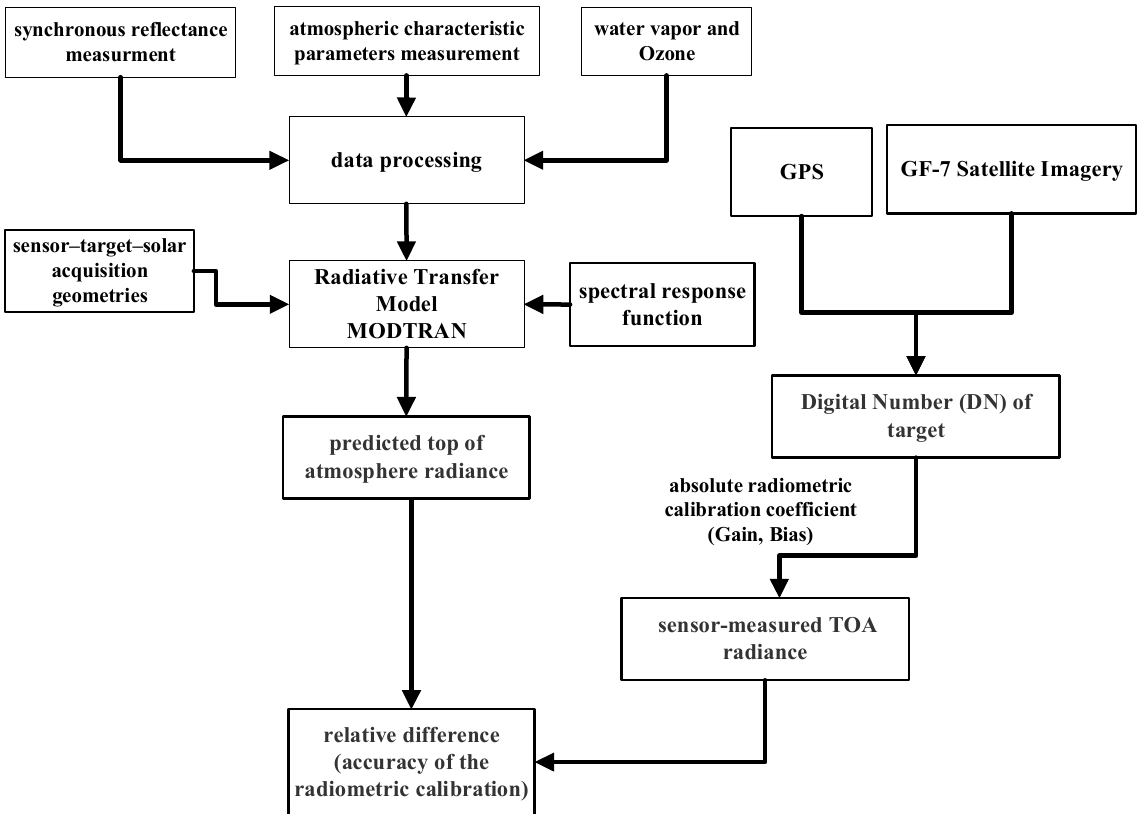
Figure 6. Detailed flow chart of the reflectance-based approach. The TOA reflectance (known as apparent reflectance) of the GF-7 satellite multispec- tral imager